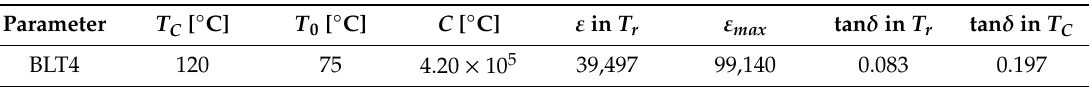
Table 3. Values of dielectric parameters of BLT4 ceramics for the frequency of the measuring field f = 1 kHz.